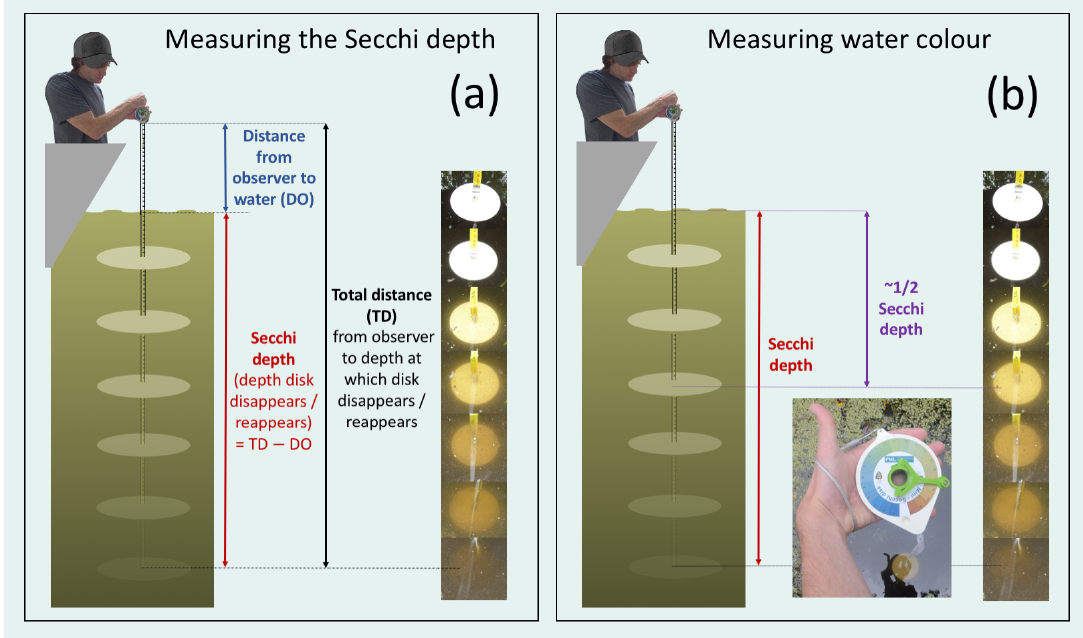
Figure 5. Measuring Secchi depth and water colour with the mini-Secchi disk. ( a ) Measuring the Secchi depth. ( b ) Measuring water colour at half the Secchi